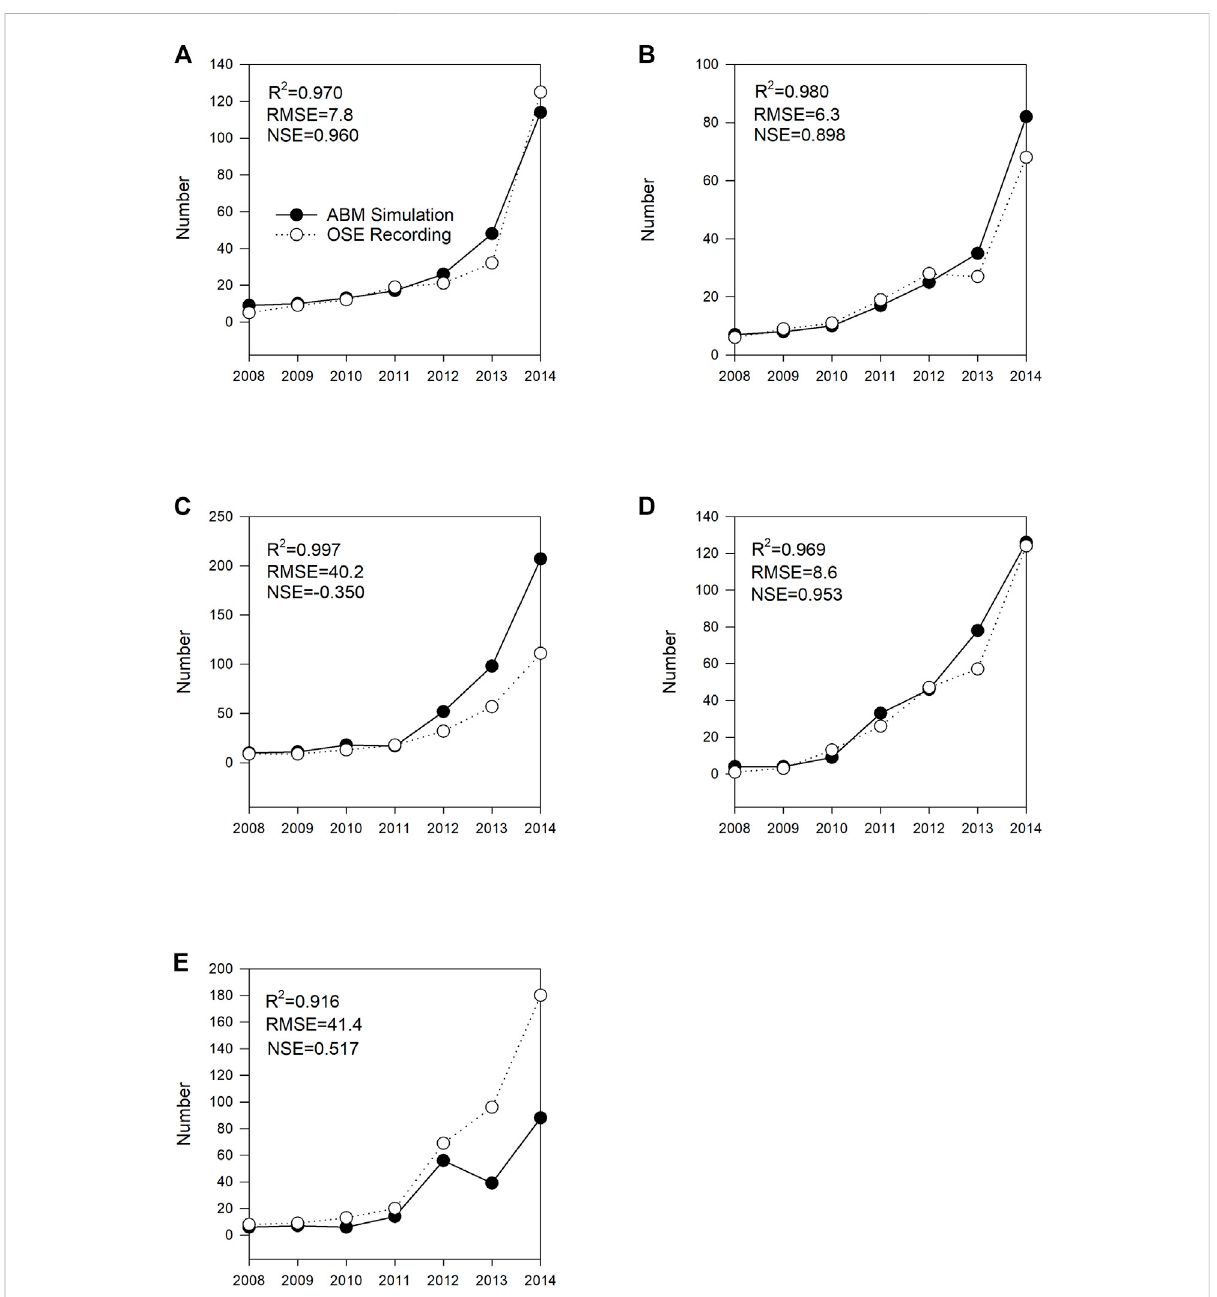
FIGURE 6 Graphical comparisons of the actual and model-simulated numbers of water depots in (A) Mountrail, (B) Dunn, (C) McKenzie, (D) Williams, and (E) other counties in western North Dakota. Notes: ABM – agent-based model, OSE – Of fi ce of the State Engineer, RMSE – Root Mean Square Error, NSE – Nash-Sutcliffe Ef fi